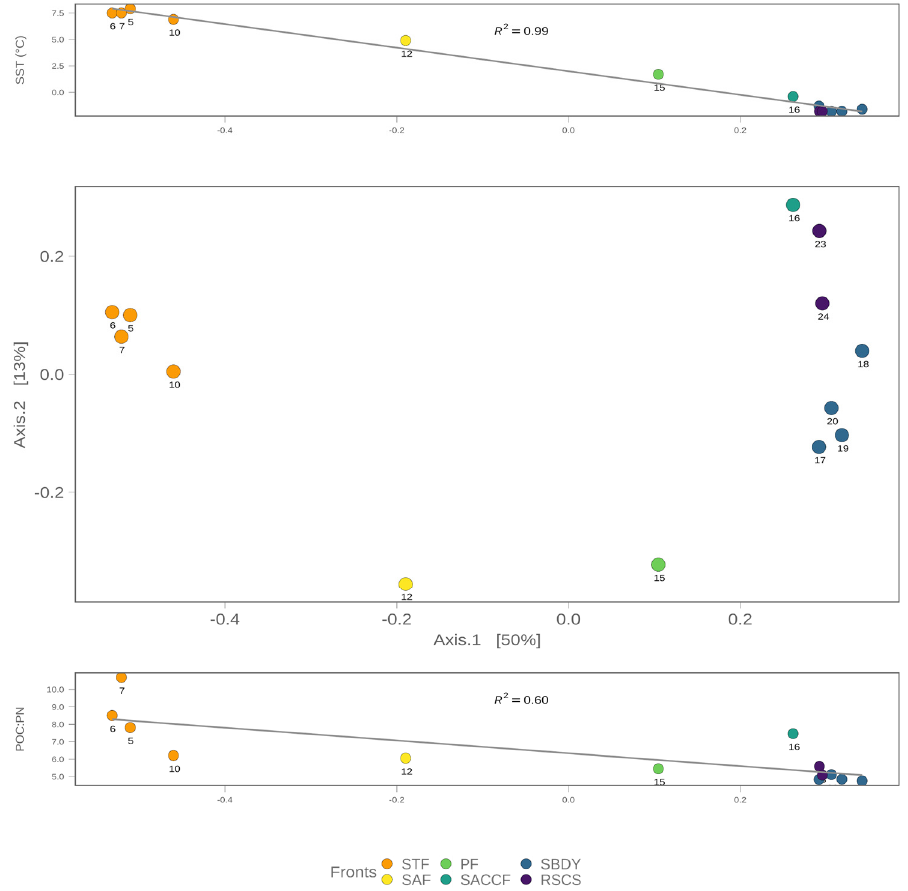
Figure 5. Principal Coordinate Analysis using a weighted Jaccard similarity distance illustrating the shifts in the community structure according to Southern Ocean waterfronts. SST—Sea Surface Temperature; POC:PN—Ratio between Particulate Organic Carbon and Particulate Nitrogen; STF—Sub-Tropical Front; SAF: Sub-Antarctic Front; PF—Polar Front; SACCF—Southern Antarctic Circumpolar Current Front; SBDY—Southern Boundary Front; RSCS—Ross Sea Continental Shelf. The amount of variance explained by each axis is reported within square brackets.